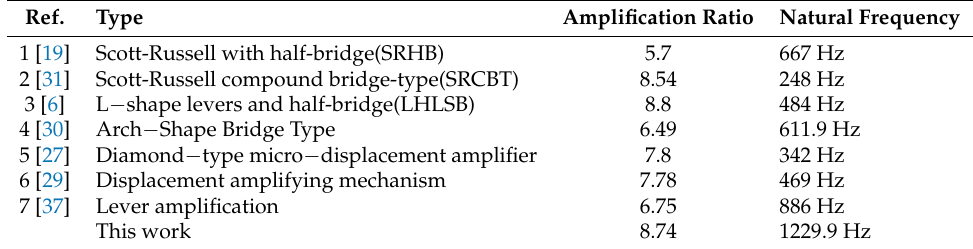
Table 5. Critical parameters of different amplifier mechanisms.